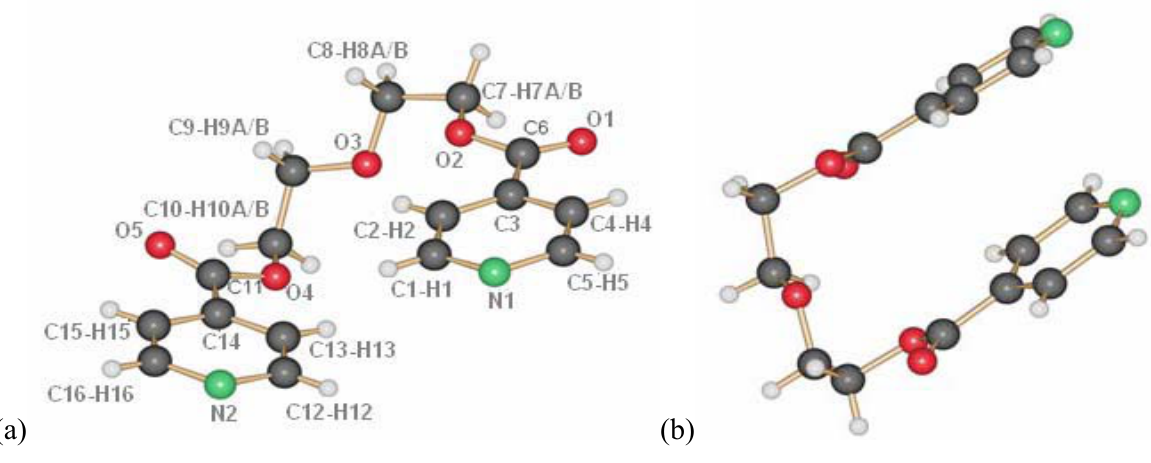
Figure 8. Ligand L2, numbering (a) and U-shape